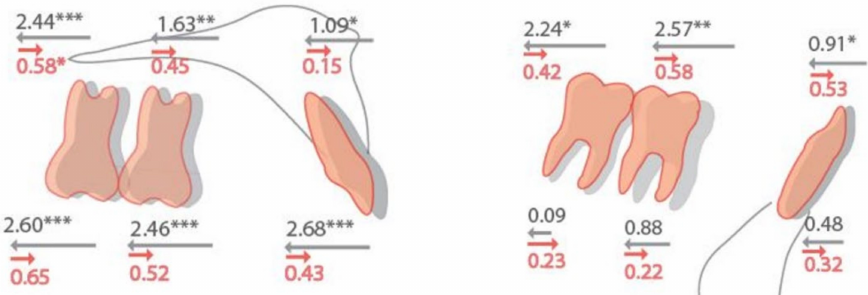
Figure 7. The schema about comparison of pretreatment to post-treatment (T1-T0) and post-treatment